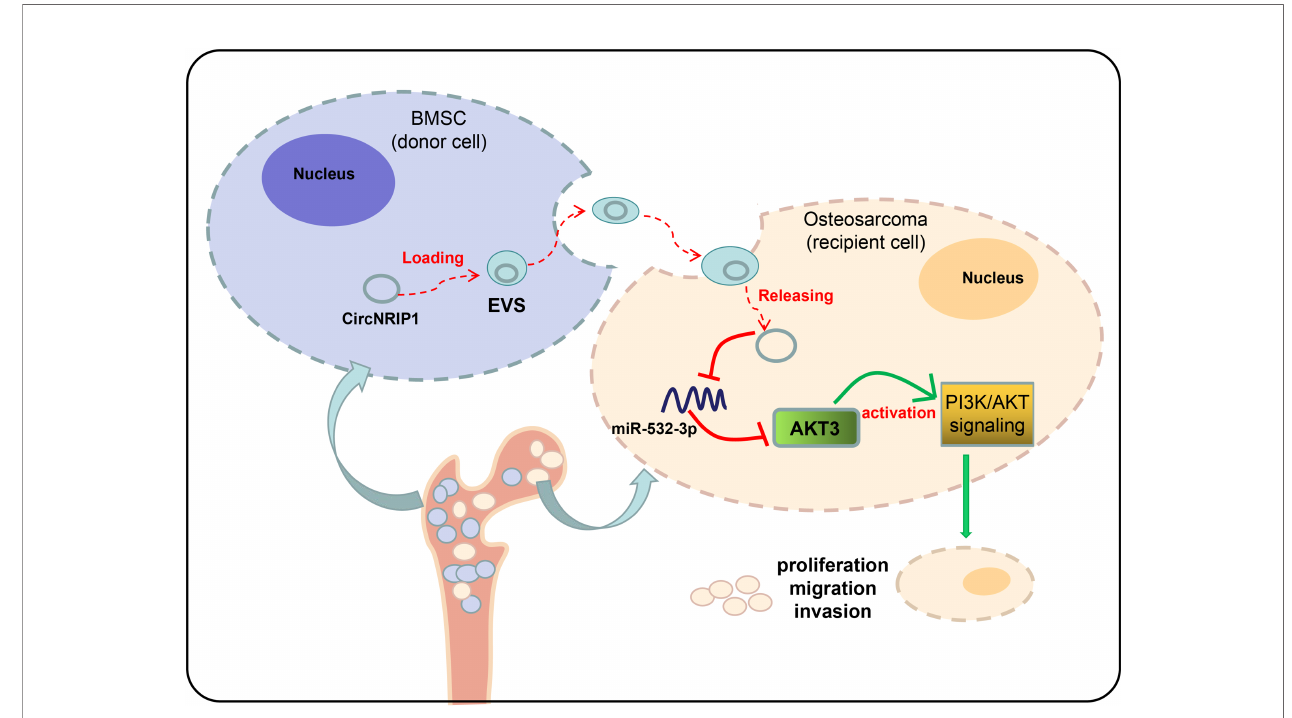
FIGURE 8 | Underlying mechanism of circNRIP1 encapsulated by BMSC-EVs in osteosarcoma. BMSC-EVs can transfer circNRIP1 to osteosarcoma cells and promote the progression of osteosarcoma by regulating the miR-532-3p/AKT3/PI3K/AKT